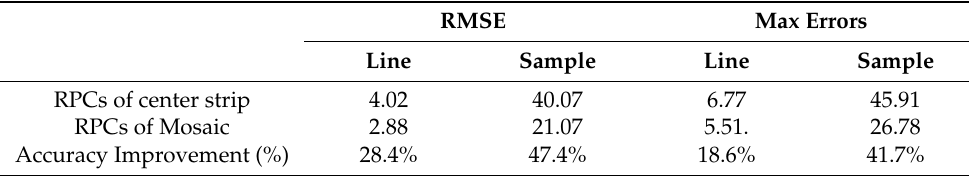
Table 3. Accuracy of mosaic strip RPCs (unit: pixels).